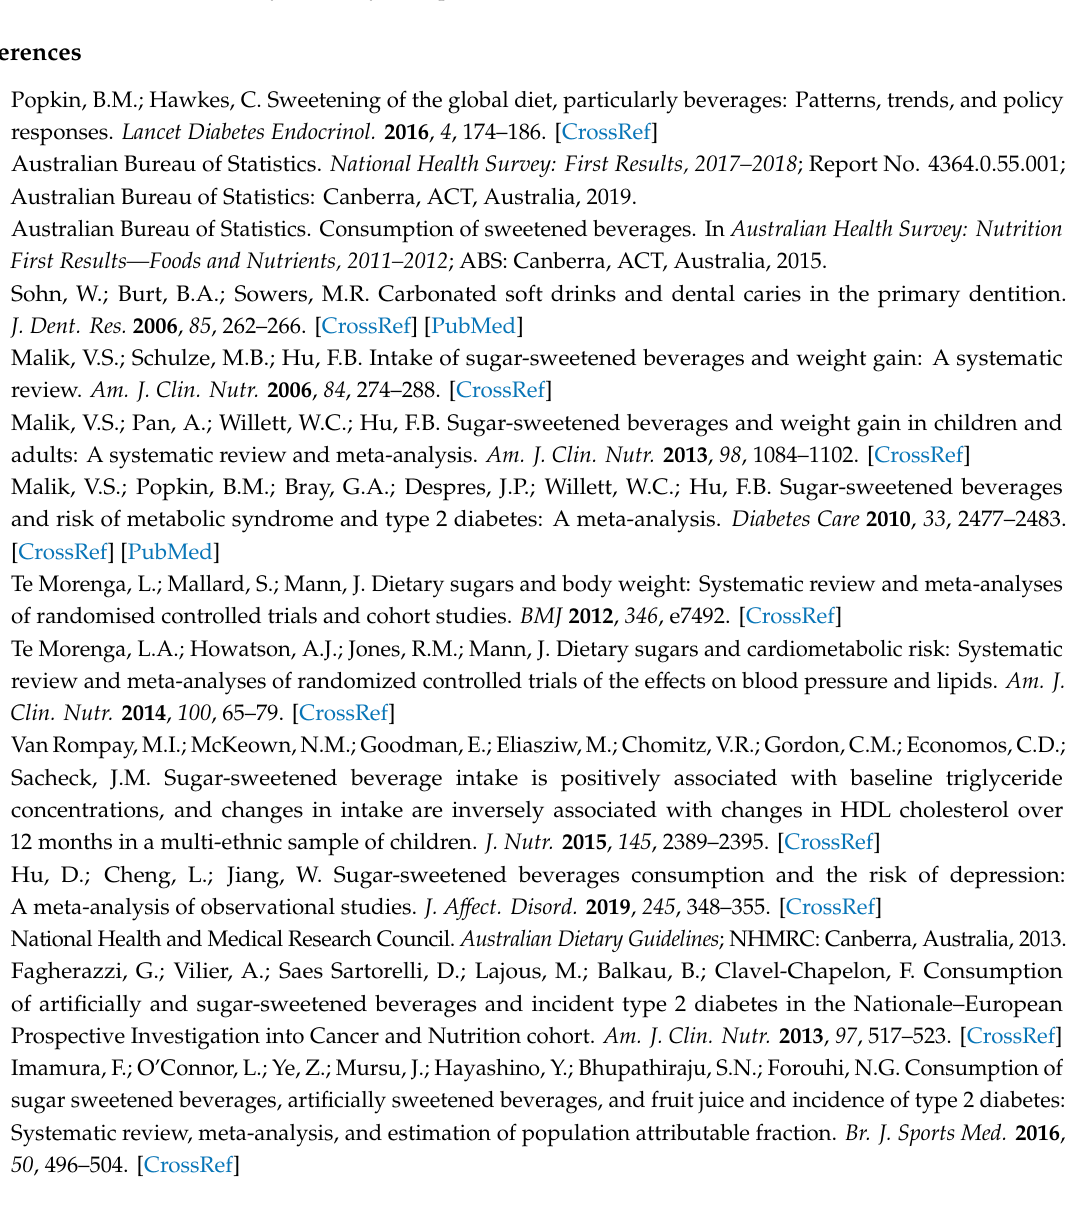
Table S1: Knowledge and beliefs related to soda consumption ( n = 3430), Table S2: Knowledge and beliefs related to diet soda